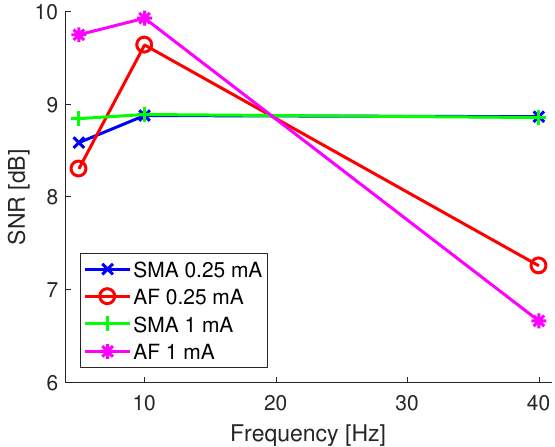
Figure 7. SNR between inputted and reconstructed EEG data collected using the phantom head after tACS artifact removal at different tACS stimulation